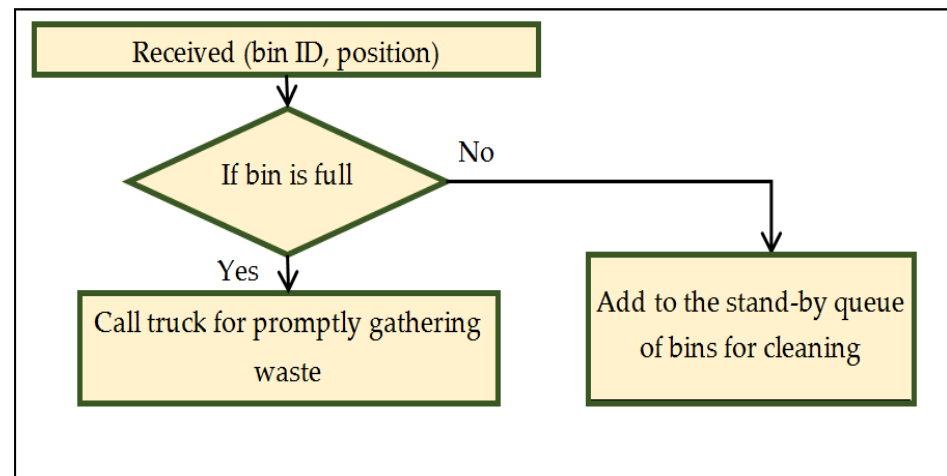
Figure 15. Procedures for decision making.